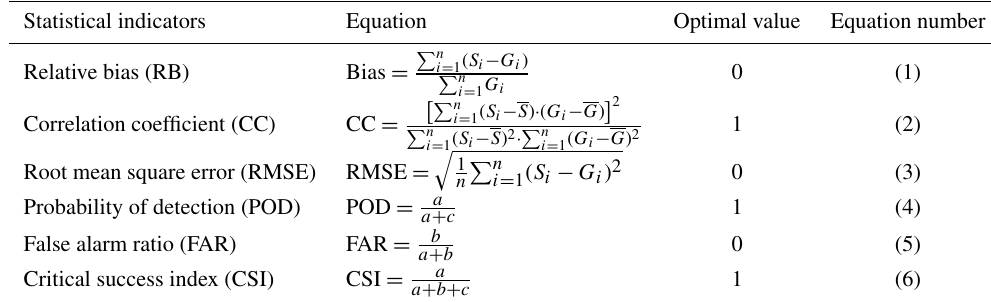
Table 3. Statistical indices that were used to assess the performance of the gridded rainfall datasets. Statistical indicators Equation Optimal value Equation